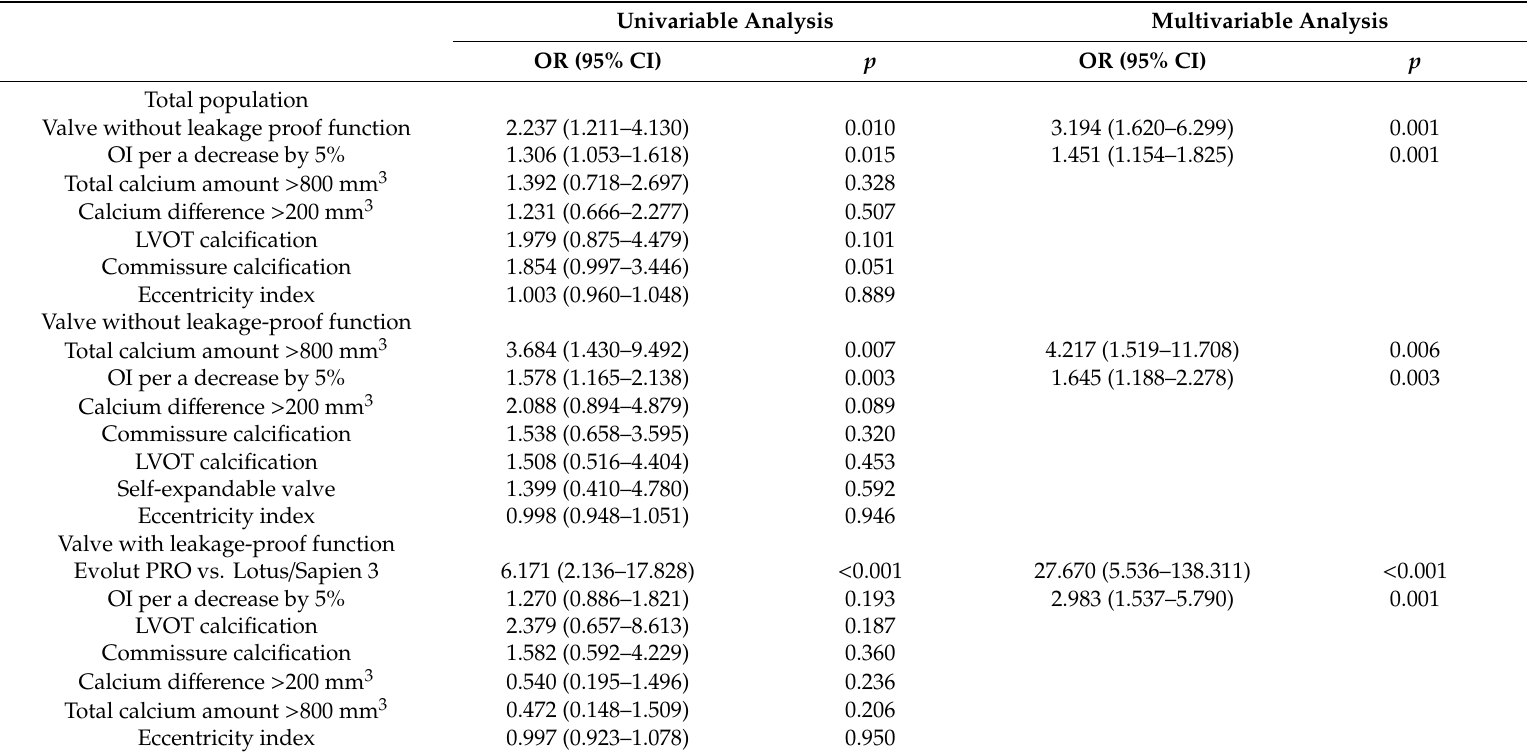
Table 3. Independent factors for mild / moderate para-valvular leakage at logistic regression analysis. Univariable